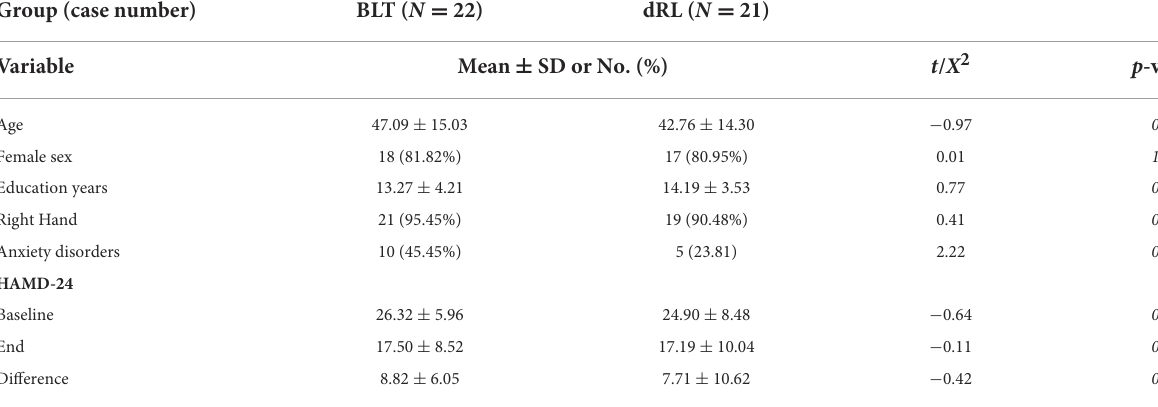
TABLE 1 Demographic data for the control and experimental